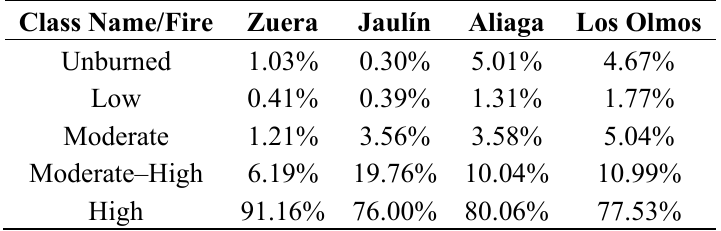
Table 12. Percentage of area by fire severity classification and